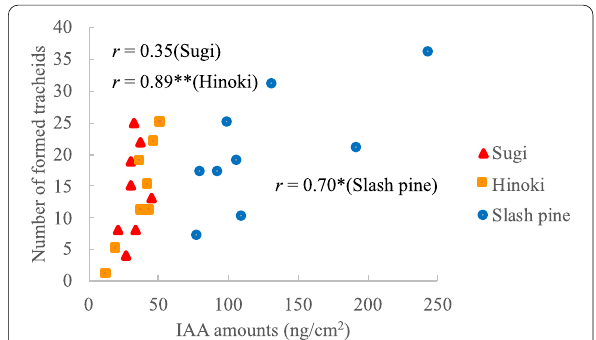
Fig. 6 Relationships between IAA levels and tracheid formation in three conifers during early season. Sugi and hinoki data were from samples collected the following April. The plotted data represent the IAA levels in the following April and the number of tracheids formed in test period